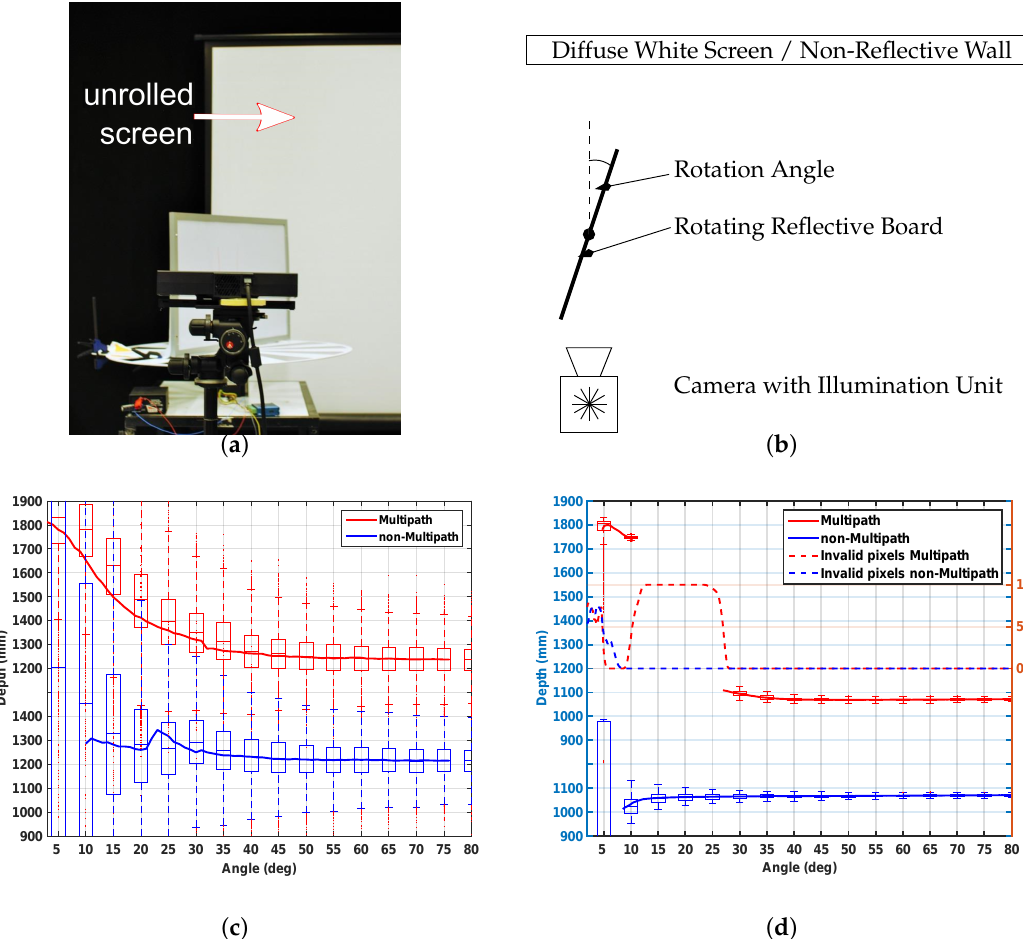
Figure 11. Reflective board scenario setup (photo ( a ) and top-view ( b )) and the multipath results for the Hamamatsu camera ( c ) and the comparison to the ( d ). ( a ) Reflective Board Setup, Photo; ( b ) Reflective Board Setup, Top View; ( c ) Result for Hamamatsu PB ToF; ( d ) Result for Kinect ToF